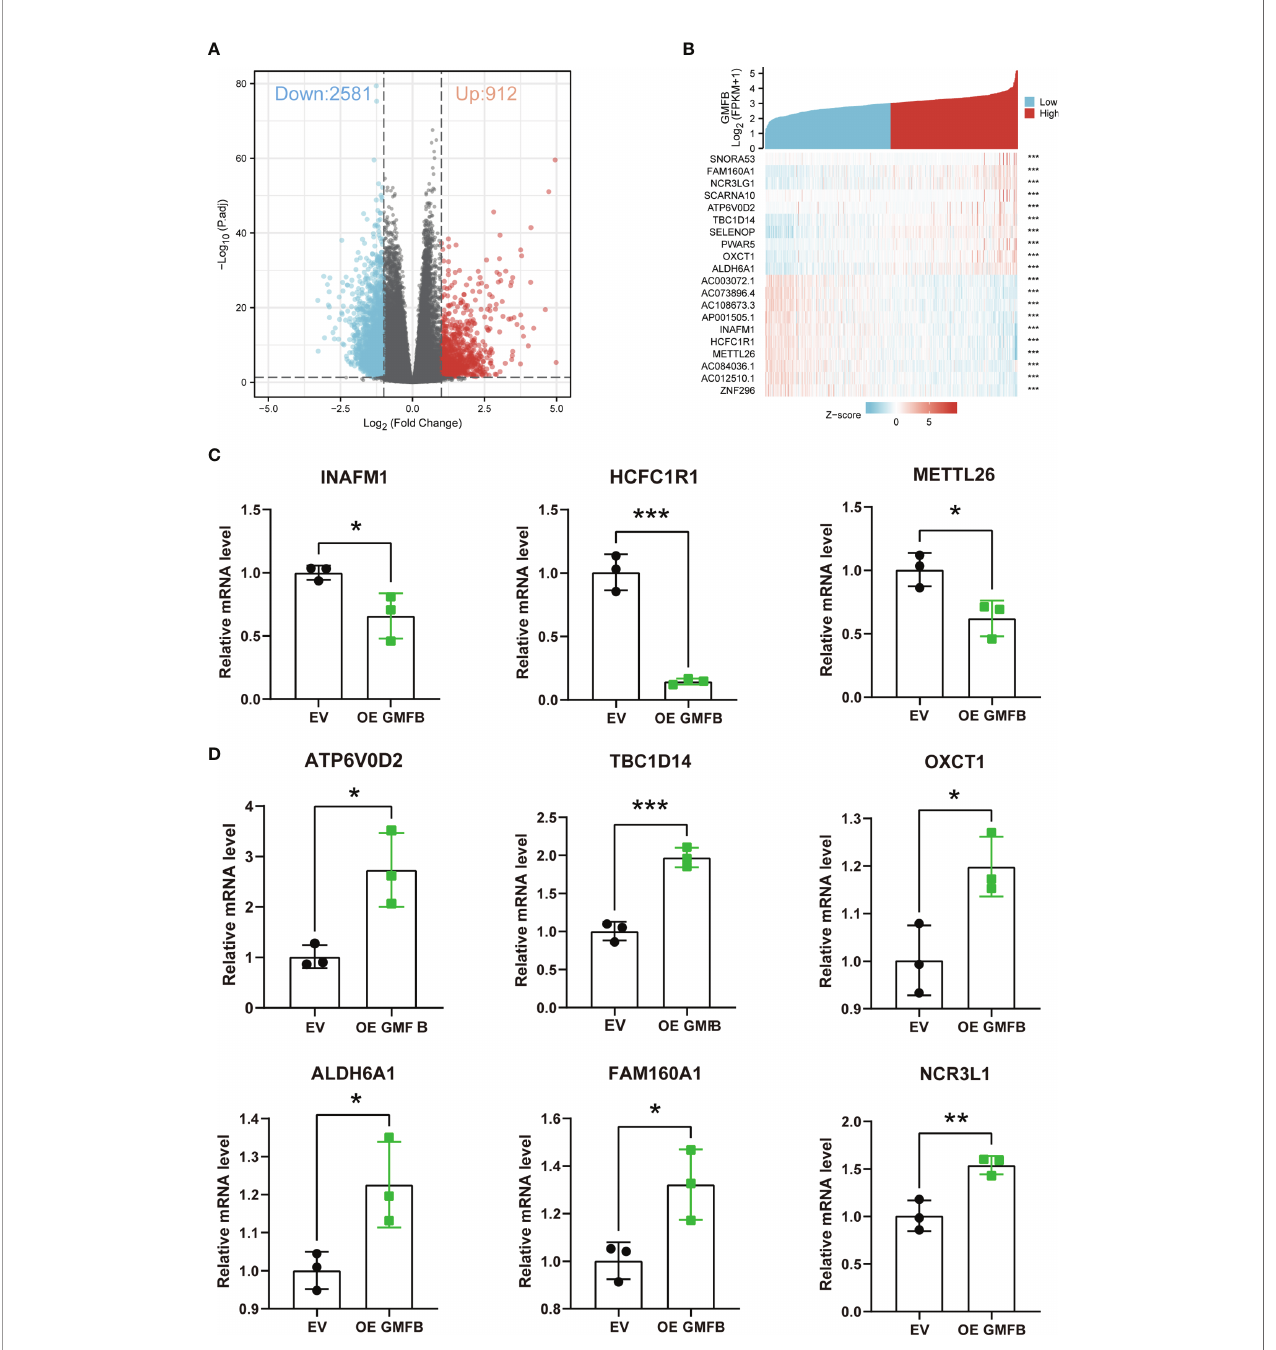
FIGURE 5 | The identi fi cation of DEGs. (A) Volcano plot of differentially expressed genes (DEGs). (B) Heatmap of DEGs. (C) Downregulated DEGs (INAFM1, HCFC1R1, and METTL26) were determined by RT-qPCR. (D) Upregulated DEGs (ATP6V0D2, TBC1D14, OXCT1, ALDH6A1, FAM160A1, and NCR3LG1) were determined by RT-qPCR. Error bars represent SD. *p < 0.05, **p < 0.01, ***p <